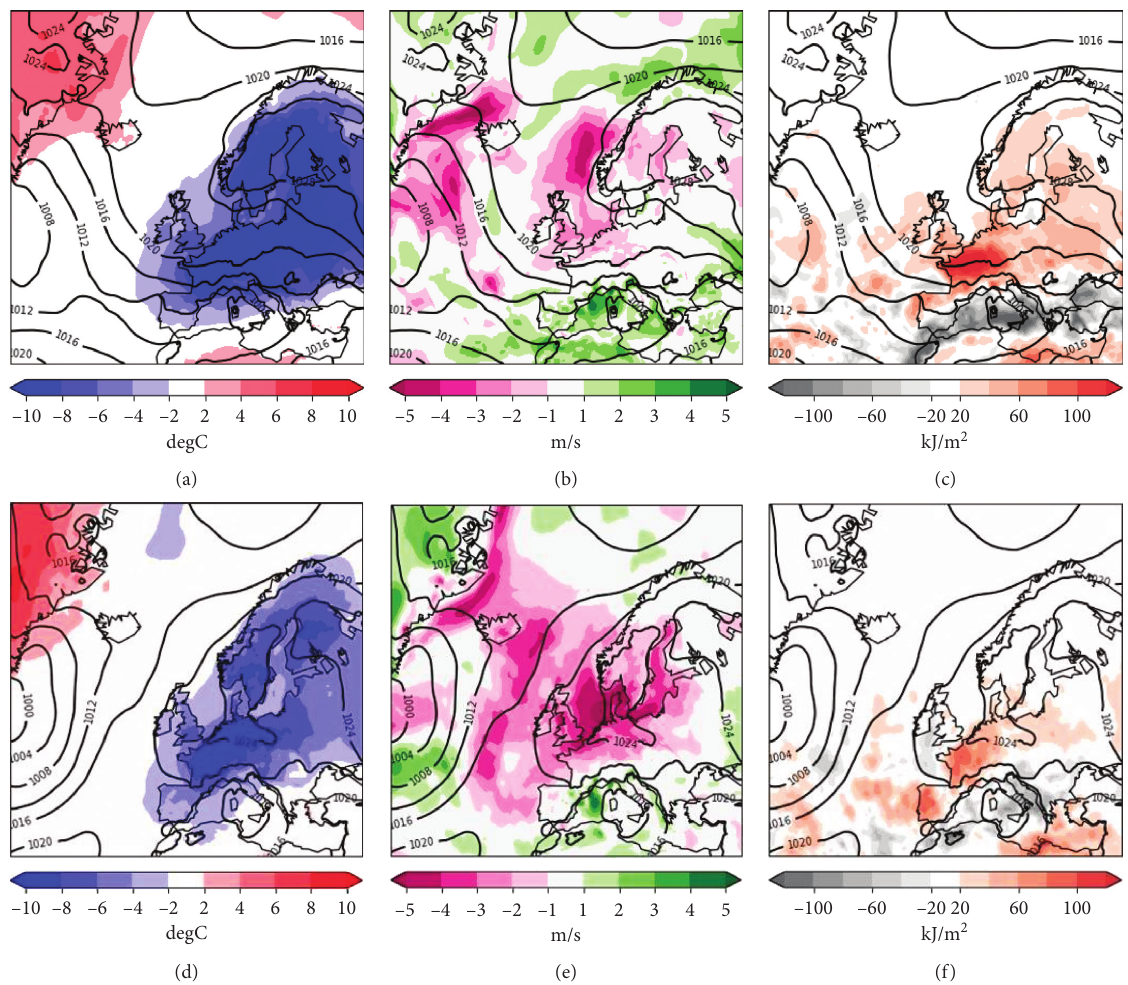
Figure 1: Anomaly composites of near-surface meteorological variables experienced during the top 10 European total peak demand events for (a) 2m temperature, (b) 100m wind speed, and (c) surface solar radiation. Contours show the mean-sea level pressure composite during the peak demand events. (d–f) as seen in (a–c) for European total peak demand-net-renewables